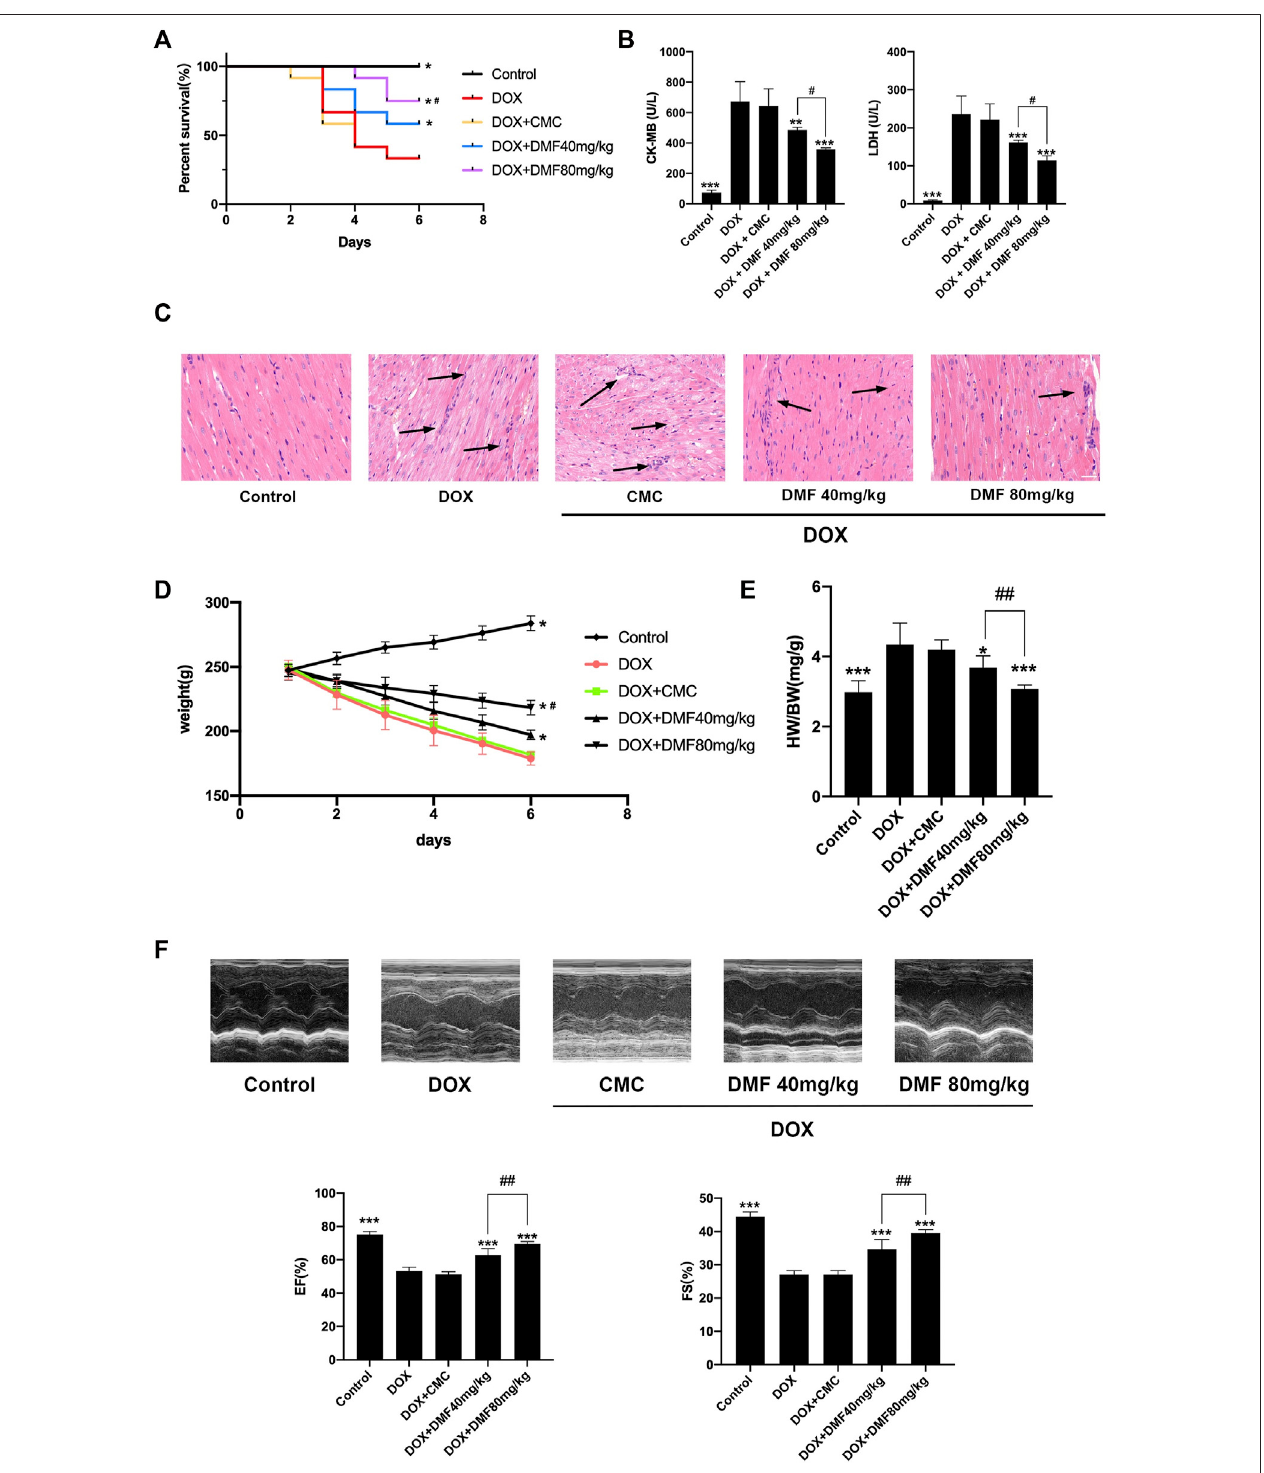
FIGURE 2 | DMF alleviated DOX-induced cardiac injury. (A) Effects of DMF on Kaplan-Meier survival curves ( n = 12). (B) Changes in serum levels of CK-MB and LDH( n =6). (C) RepresentativeH&Estainingofhearts(Blackarrowsindicatethecardiacinjurysites, n =6,scalebar=20 μ m) (D) Changesinthebodyweights( n =6). (E) Changes in HW/BW (mg/g) ( n = 6). (F) Representative M-mode echocardiograms and quantitative analysis of LVEF and FS( n = 5). Data were presented as the mean ± SD. * p < 0.05, ** p < 0.01, *** p < 0.001, compared with DOX group. # p < 0.05, ## p < 0.01, compared with DOX + DMF 40 mg/kg group. HW: heart weight; BW: body